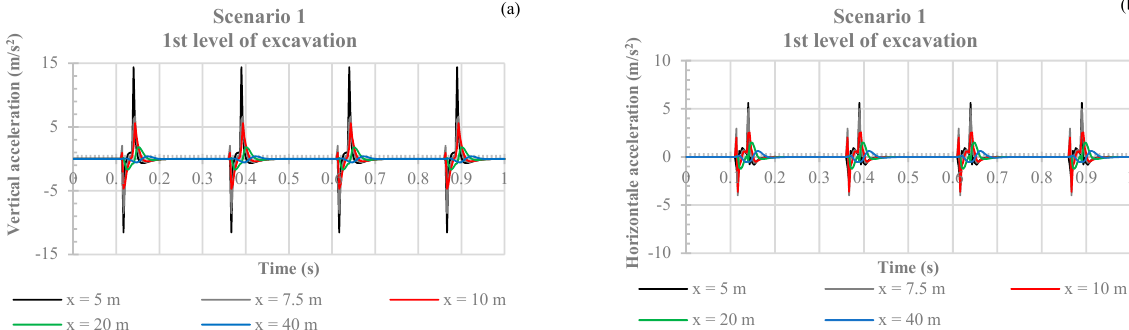
Figure 5. Traditional excavation technique (Scenario 1): ( a ) vertical and ( b ) horizontal acceleration time histories obtained at different distances from the symmetry axis during the second excavation stage.